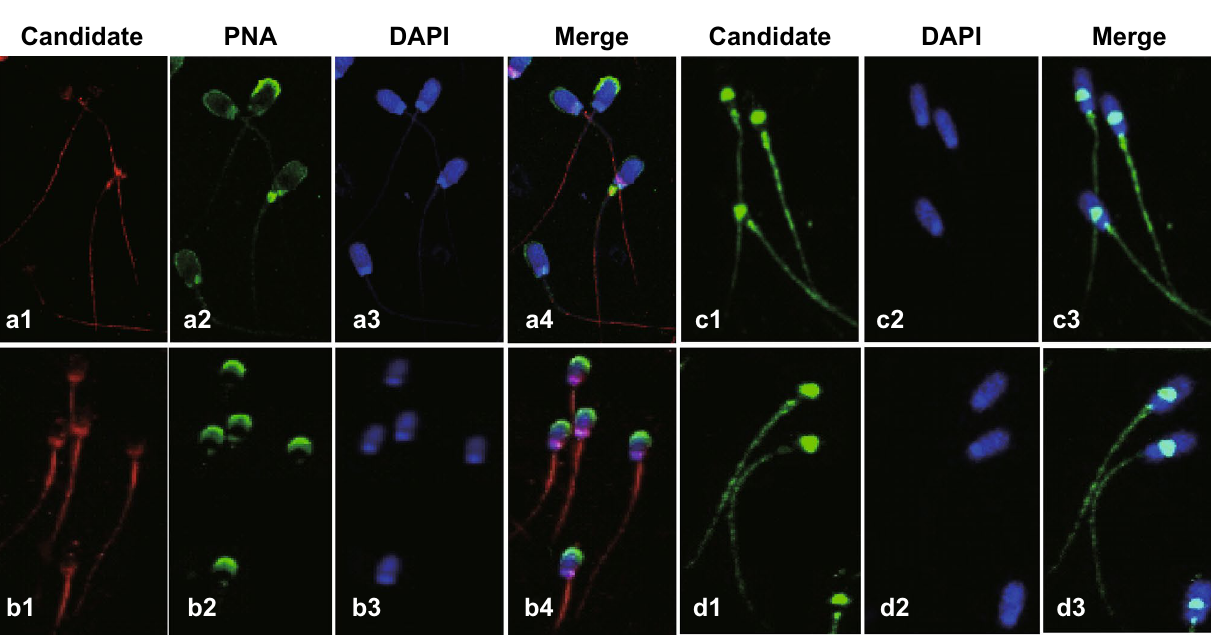
Fig. 5 Immunolocalization of phosphorylated PKA substrates (a1–4 are the control; b1–4 are in the presence of 2 μg mL −1 carboxylated C 60 ) and tyrosine-phosphorylated (c1–3 are the control; d1–3 are in the presence of 2 μg mL −1 carboxylated C 60 ) proteins in boar sperm. Sperm were incubated in the basal medium in the presence or absence of 2 μg mL −1 carboxylated C 60 with primary anti-P-PKAs and anti-phosphotyrosine antibody. PNA (peanut agglutinin) was applied to stain the acrosome and DAPI to stain the nuclei of sperm. The merged images are also shown. The experiment was performed at least three times, and the image presented is representative and repeatable. Sperm cells were visualized using a confocal laser scanning microscope (×